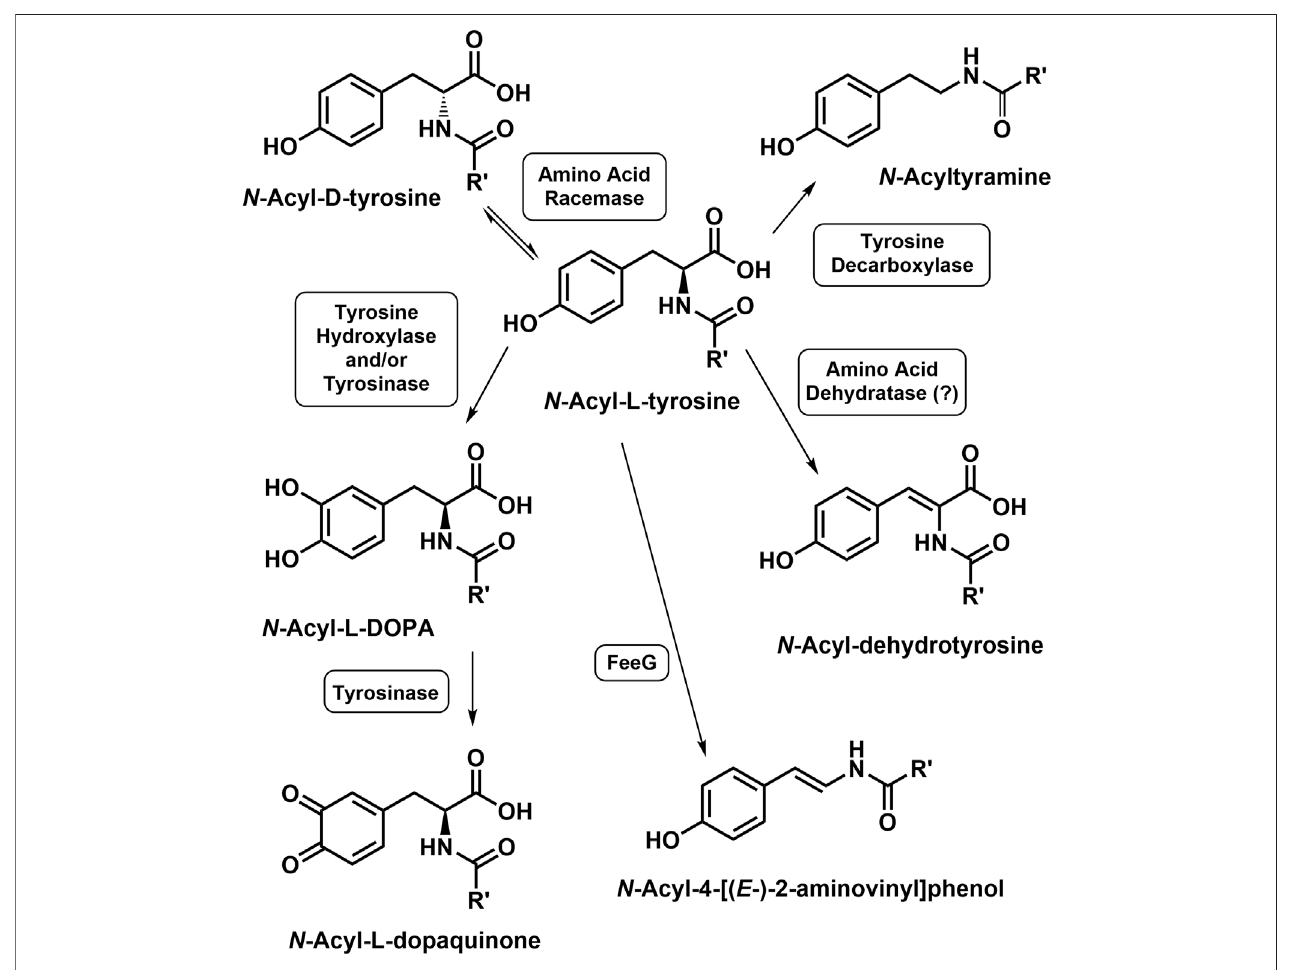
FIGURE 4 | Modi fi cations of the Tyrosyl Moiety of the N-Acyl-L-Tyrosines. An enzyme catalyzing the conversion of N -acyl-L-tyrosine to the corresponding N -acyl- dehydrotyrosine is unknown, suggested to be an N -acyl amino acid dehydratase by Sandargo et al. (2020).